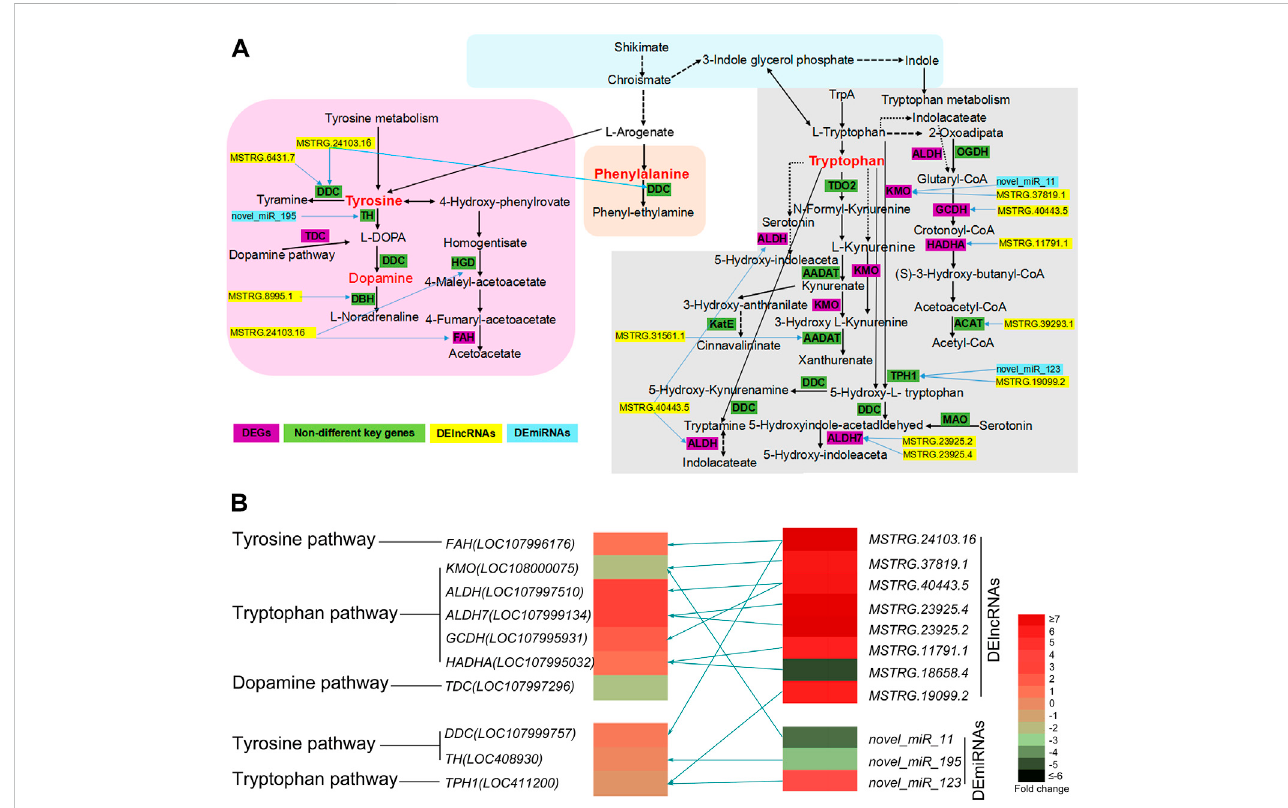
FIGURE 3 (A) The predicted KEGG network of honeybee body color alternation in nutritional crossbreed. This network is based on four key KEGG pathways includingtyrosine,tryptophan,dopamine,andphenylalaninepathways.ThekeyDEGs,DElncRNAsandDEmiRNAsinvolvedinthisnetworkarealsopresented. YellowbarsrepresentDElncRNAs,skybluebarsrepresentDEmiRNAs, andpurplebarsrepresentDEGsandgreenbarsrepresentkeygenesbutnotDEGs.Blue arrows mean DElncRNAs or DEmiRNAs involved into the regulation of related genes. (B) The heatmap of key DEGs, DElncRNAs and DEmiRNAs are involvedintothreekeyKEGGpathways.Differentcolorsrepresentsigni fi cantlydifferentialexpressionofkeyDEGs,DElncRNAsandDEmiRNAsusingtheirlog2 (Fold change) values. Olive green arrows represent the regulatory relationship between key DEGs and non-coding RNAs (DElncRNAs and